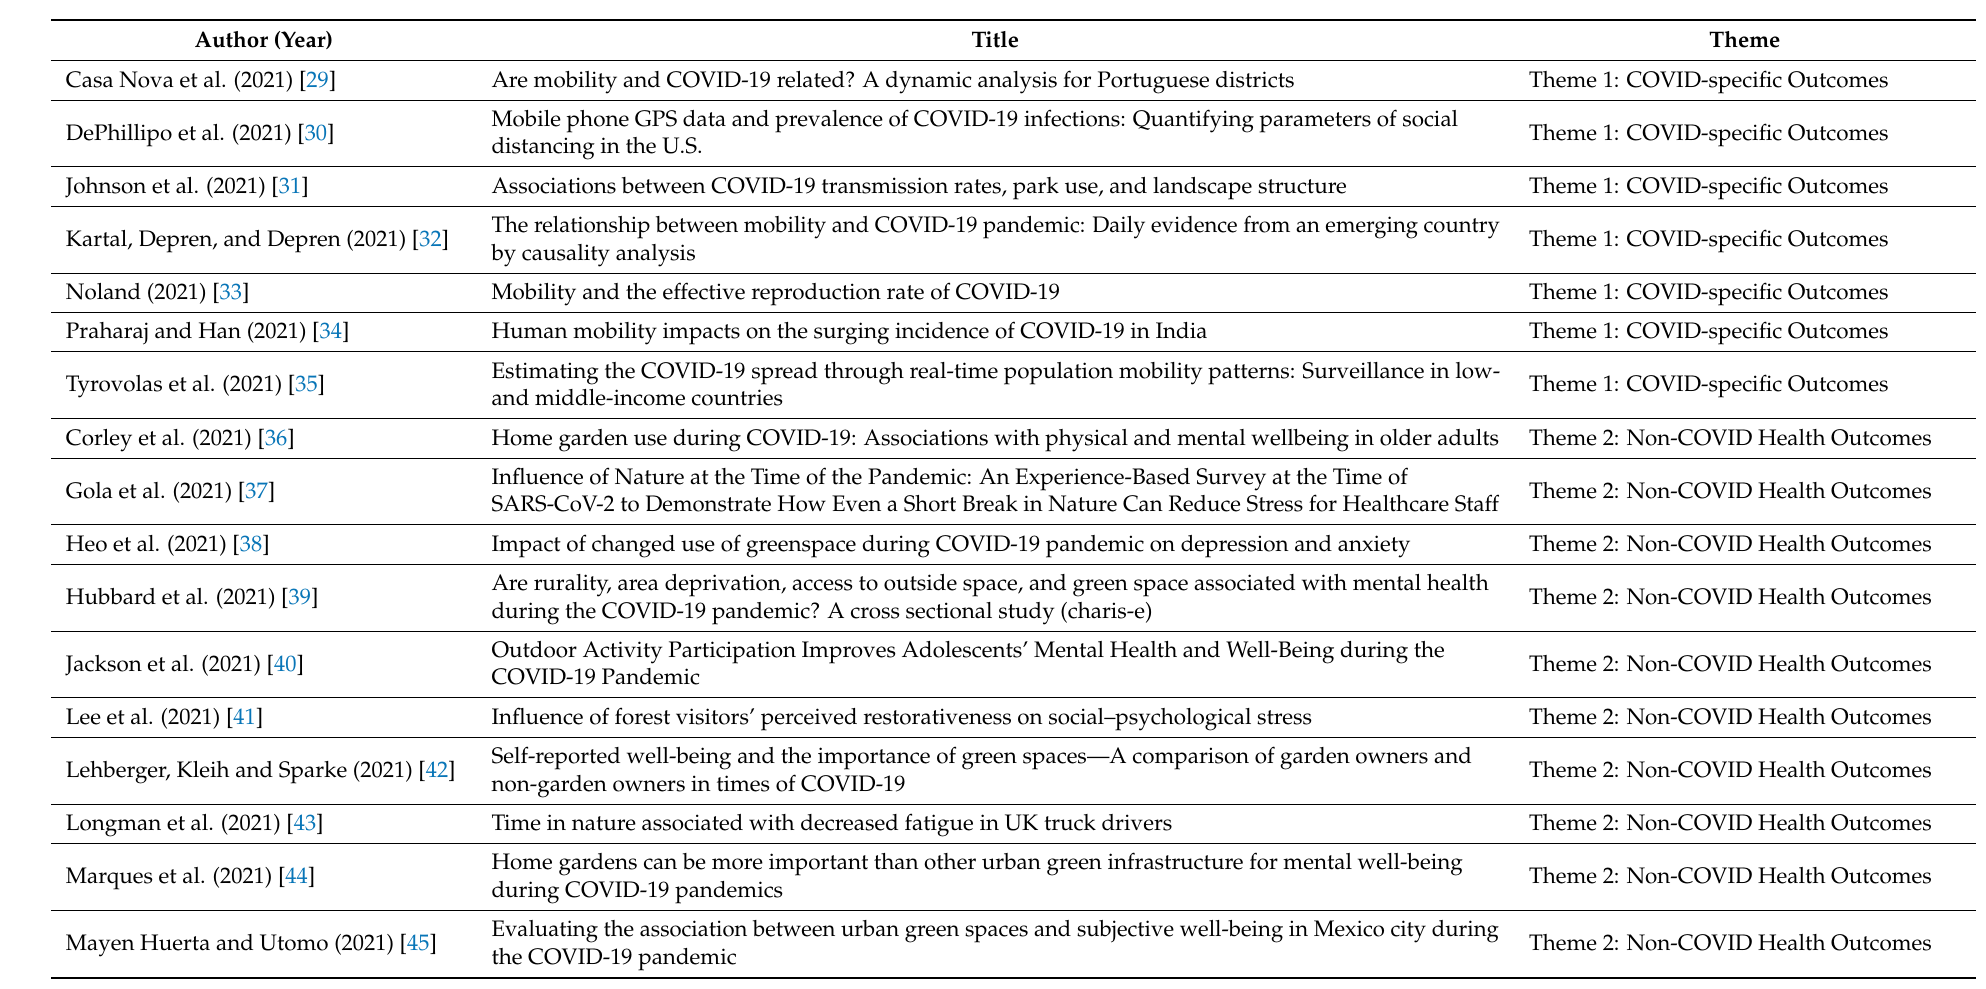
Table A1. Authors, title, and theme for all included